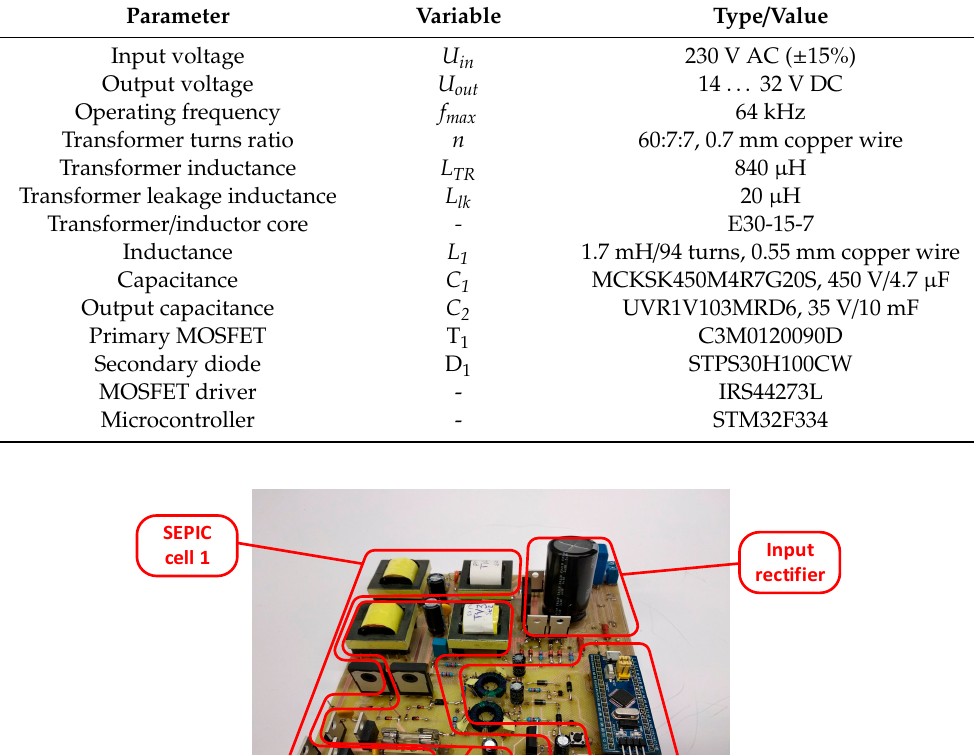
The experimental input current and voltage waveforms are presented in Figure 18 (a) and (b).